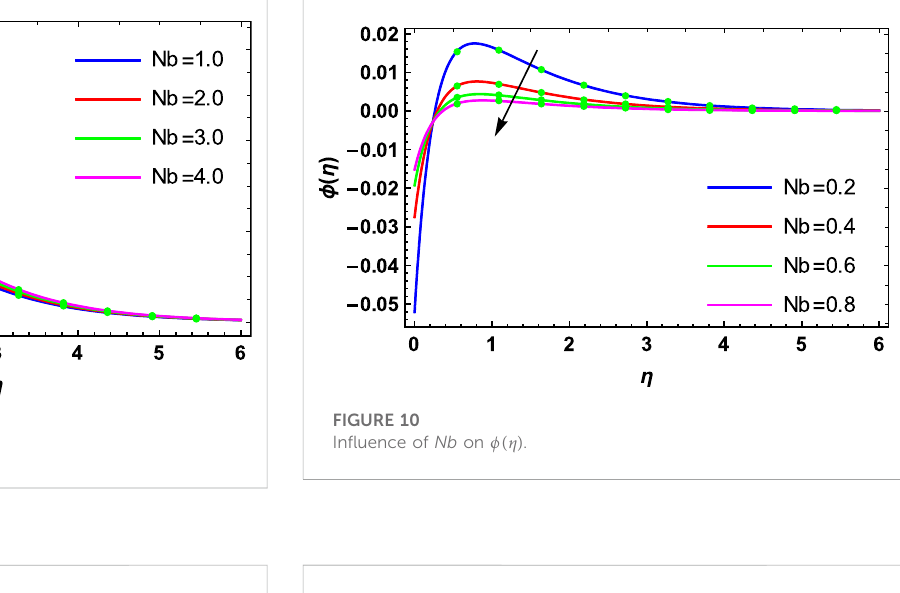
FIGURE 7 In fl uence of Nb on θ ( η ) .